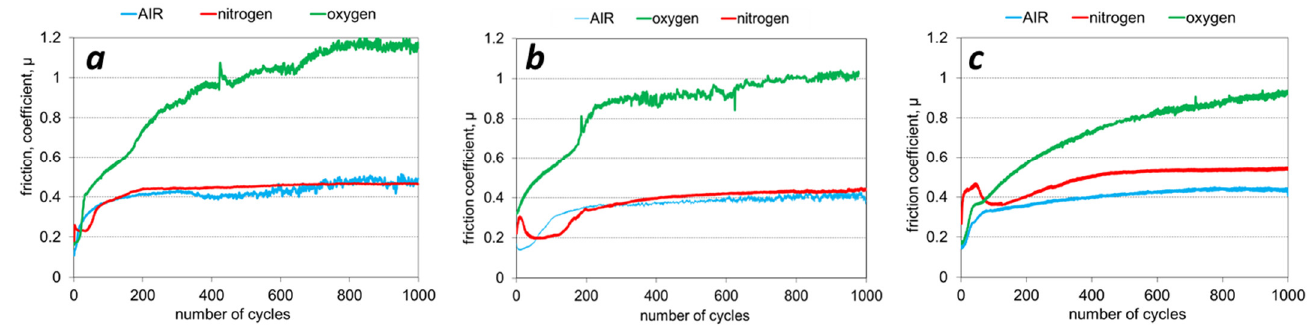
Figure 9. The friction curves of as-deposited BAI ( a ), CC7 ( b ), and AIP TiN coatings ( c ) for the tests performed at room temperature in different atmospheres (ambient air, nitrogen and oxygen) under a load of 5 N.